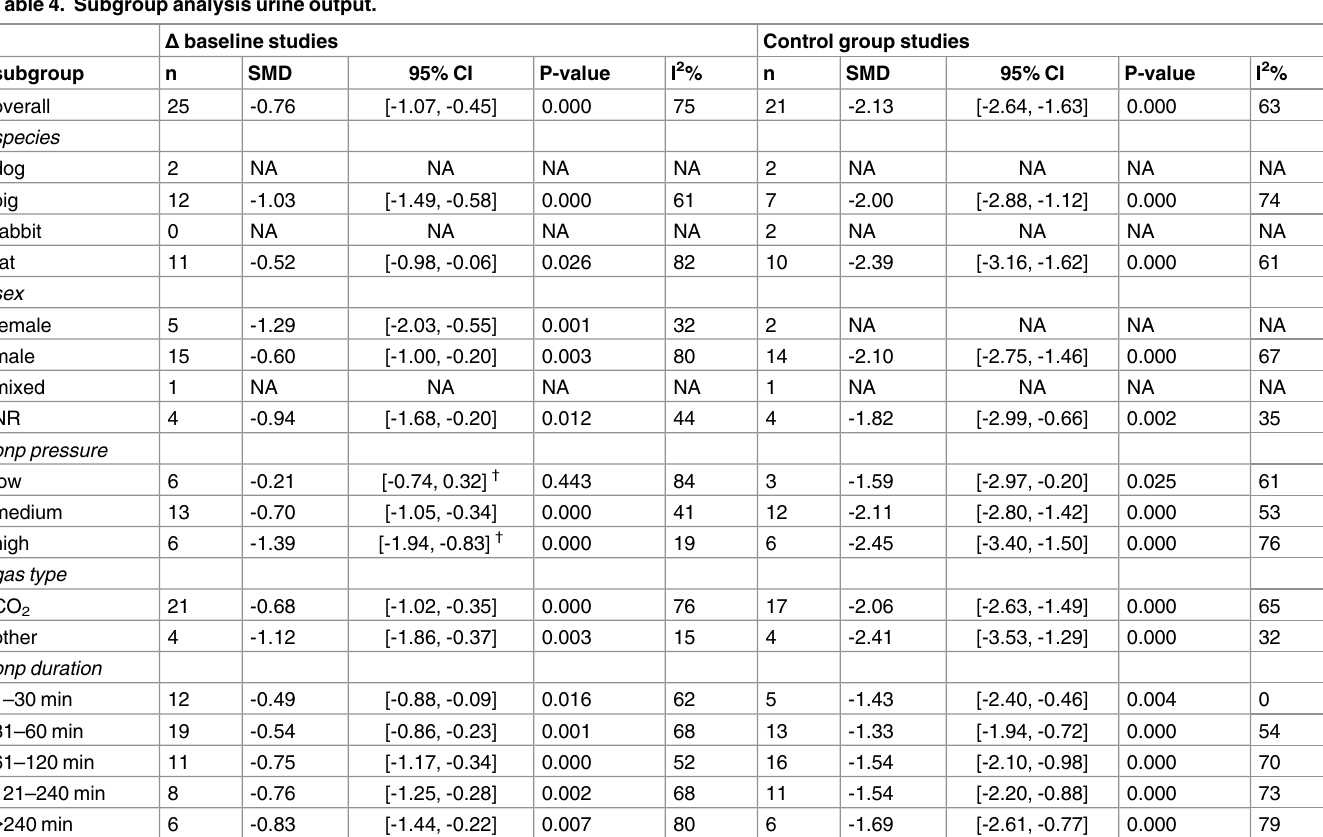
Table 4. Subgroup analysis urine